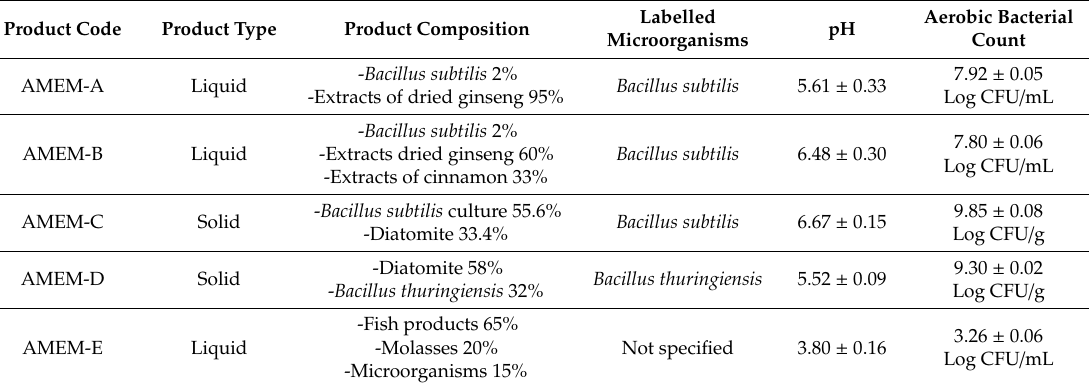
Table 1. Specification of di ff erent commercially available organic agriculture materials enriched with e ff ective microorganism.